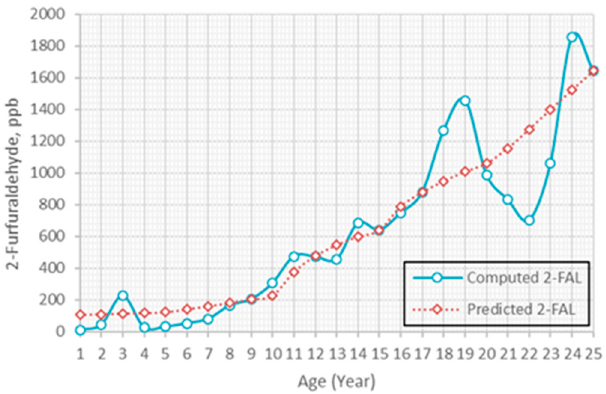
Figure 6. Comparison between computed and predicted 2-FAL.